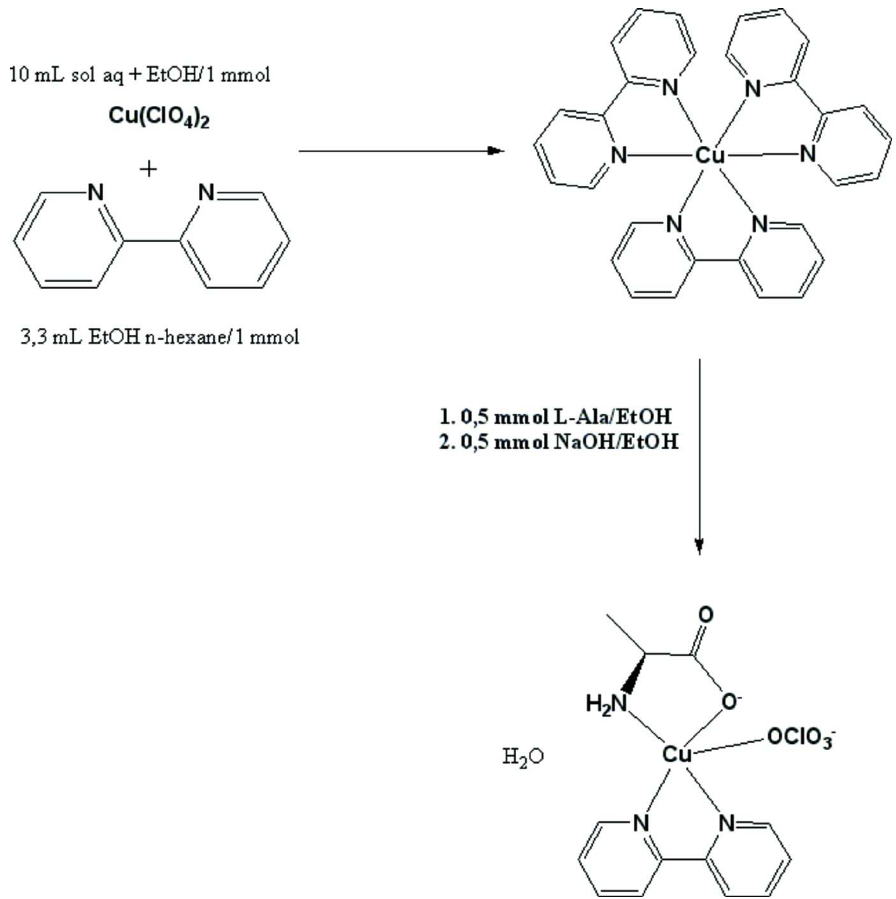
The formation of the title